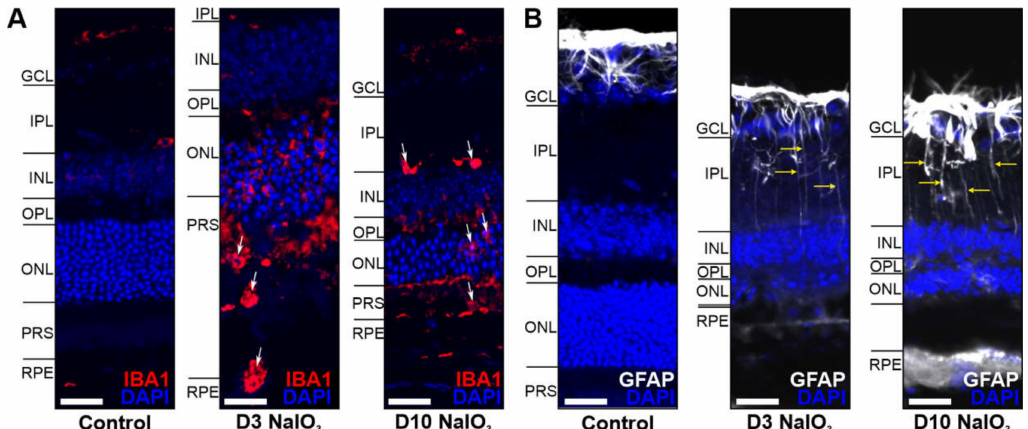
Figure 7. Glia cells were activated in the NaIO 3 -damaged retina. ( A ) Microglia/monocytes (arrows) migrated into the photoreceptor outer segment layer at day 3 following the NaIO 3 treatment and were localised in the IPL at day 10. ( B ) GFAP (white), a marker for activated Müller cells, was enhanced in the GCL after NaIO 3 treatment during the investigated period. Scale bar: 20 µ